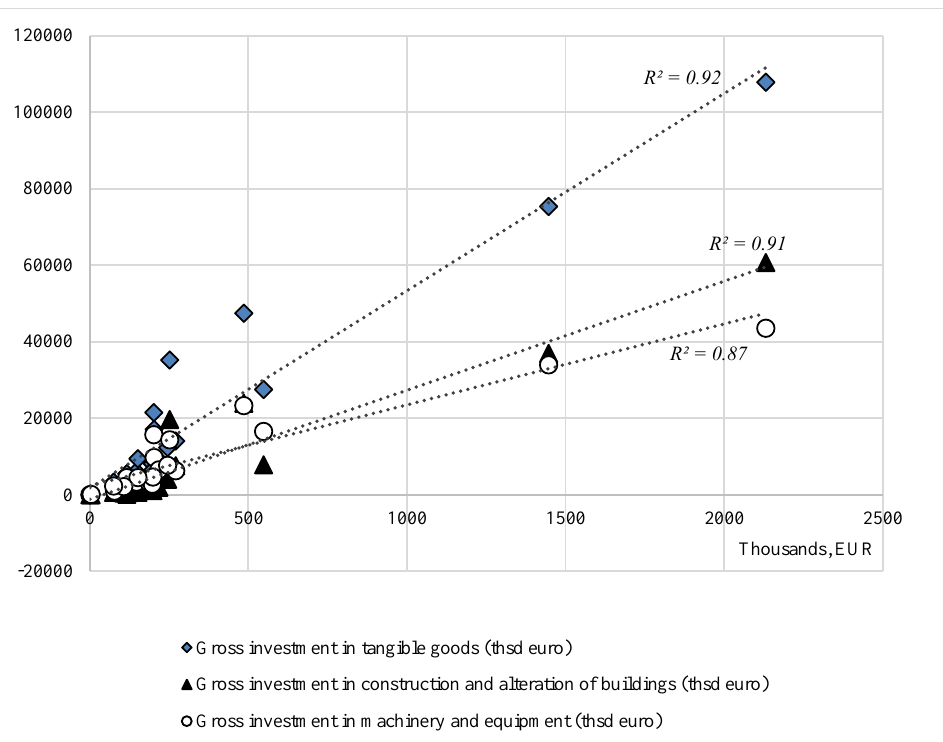
Fig. 3. Regression between sector turnover and investments into tangible